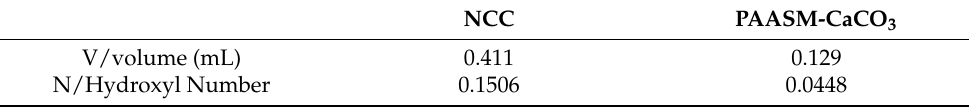
Table 2. Surface hydroxyl number test of NCC before and after